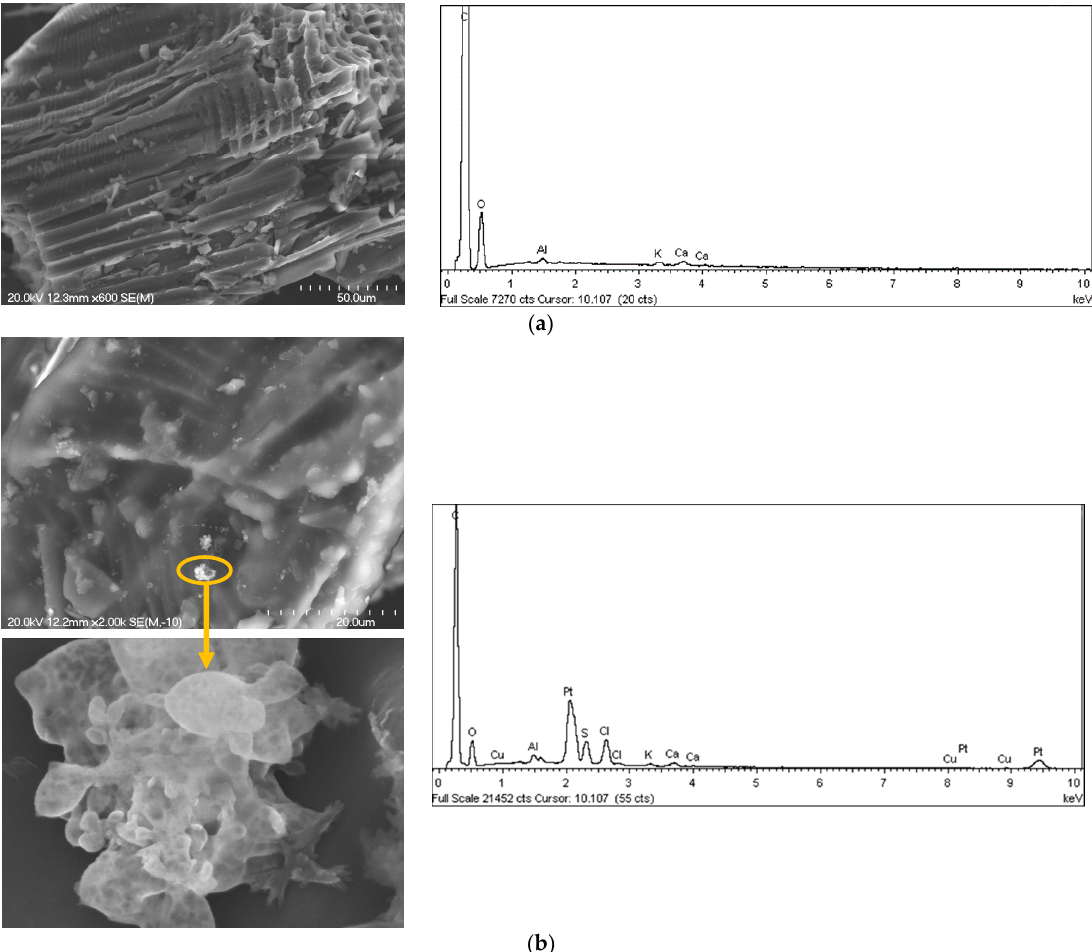
Figure 1. Scanning electron microscopy (SEM) images and energy-dispersive X-ray (EDX) spectra of biochar for the: ( a ) unimpregnated support; and ( b ) impregnated with Pt 3 wt % prior to the reaction.